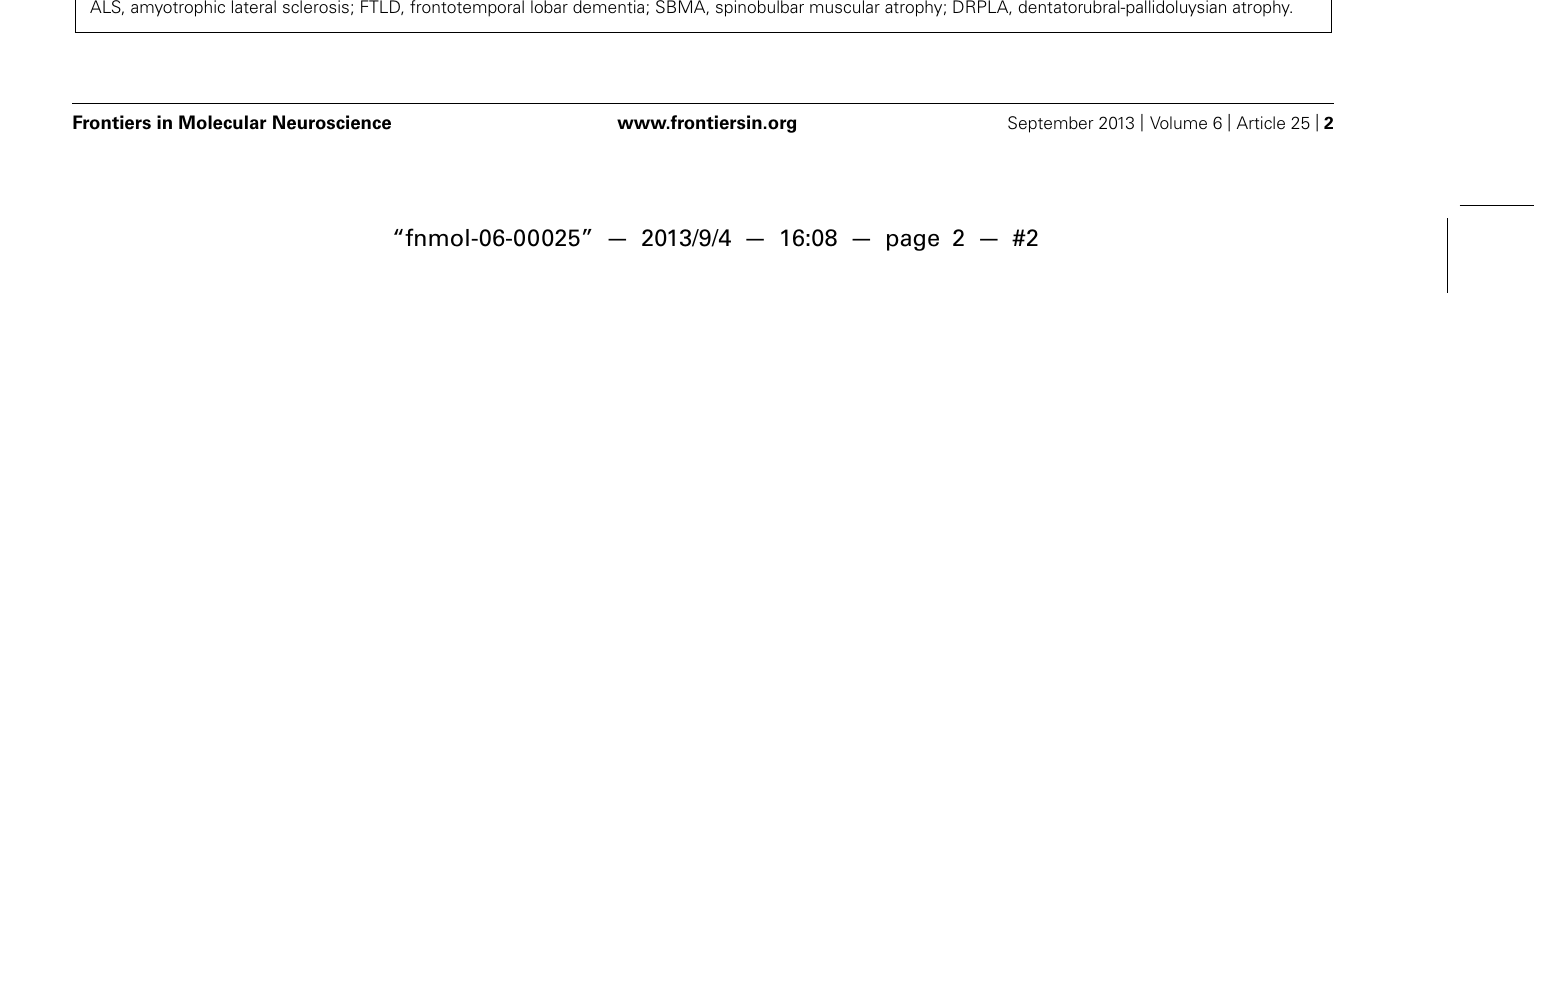
FIGURE 1 | Location of expanded repeats in disease genes. SCA, spinocerebellar ataxia (multiple loci numbered); FXTAS, fragile X tremor ataxia syndrome; ALS, amyotrophic lateral sclerosis; FTLD, frontotemporal lobar dementia; SBMA, spinobulbar muscular atrophy; DRPLA, dentatorubral-pallidoluysian atrophy.